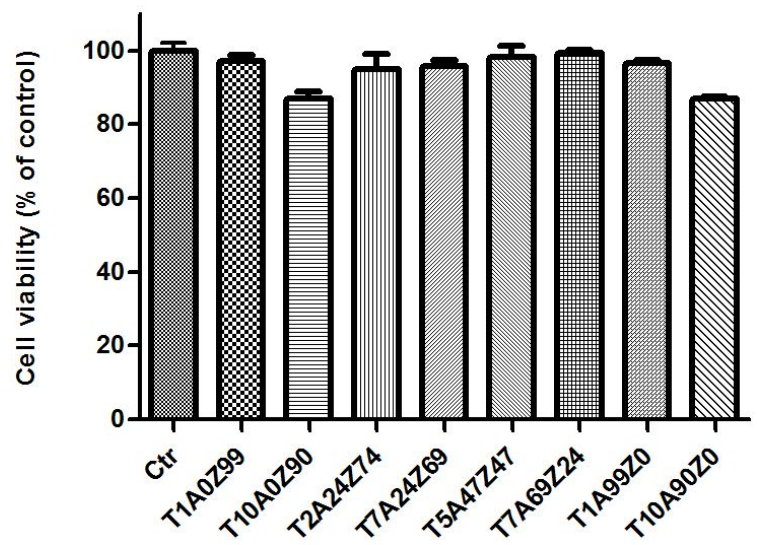
Figure 2. Cell viability of human gingival fibroblast (HGF-1) cells cultured on the composite samples for three days.